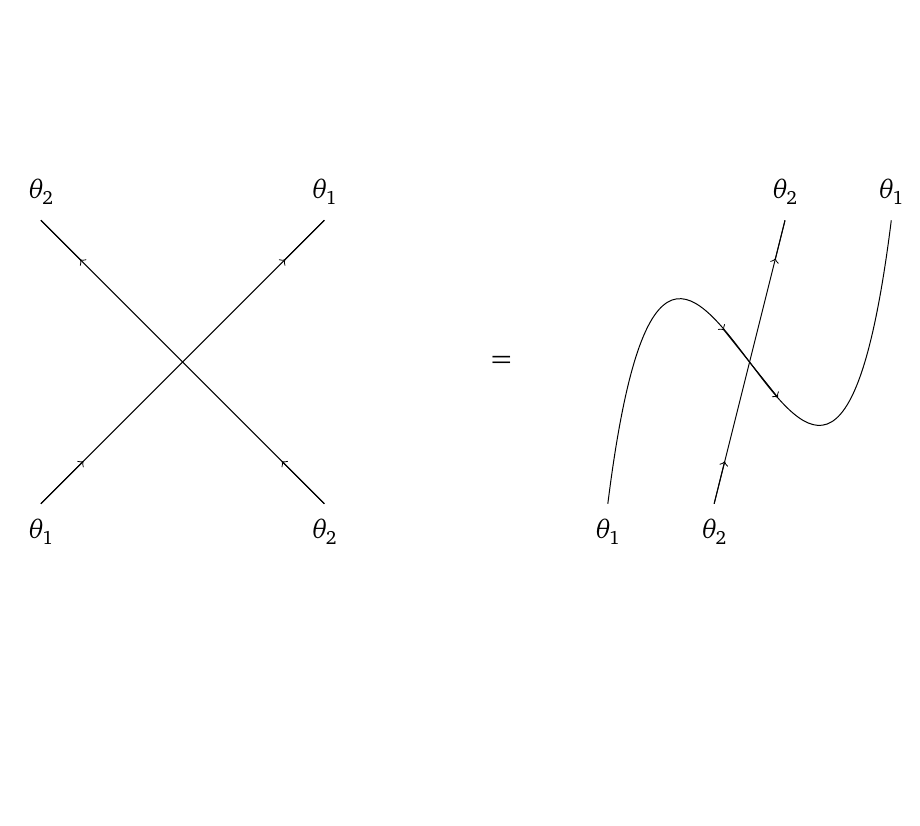
Figure 3: Crossing